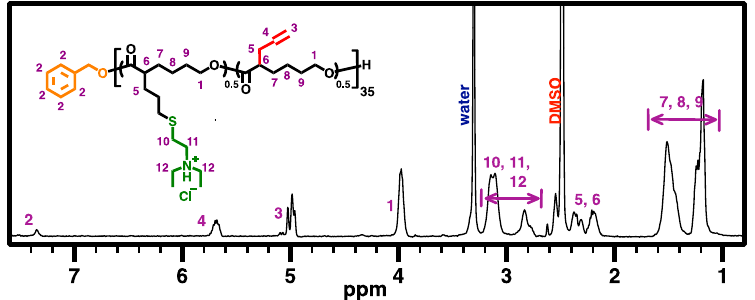
Figure 6. 500 MHz 1 H NMR spectrum of CPCL-50 in DMSO-d 6 .